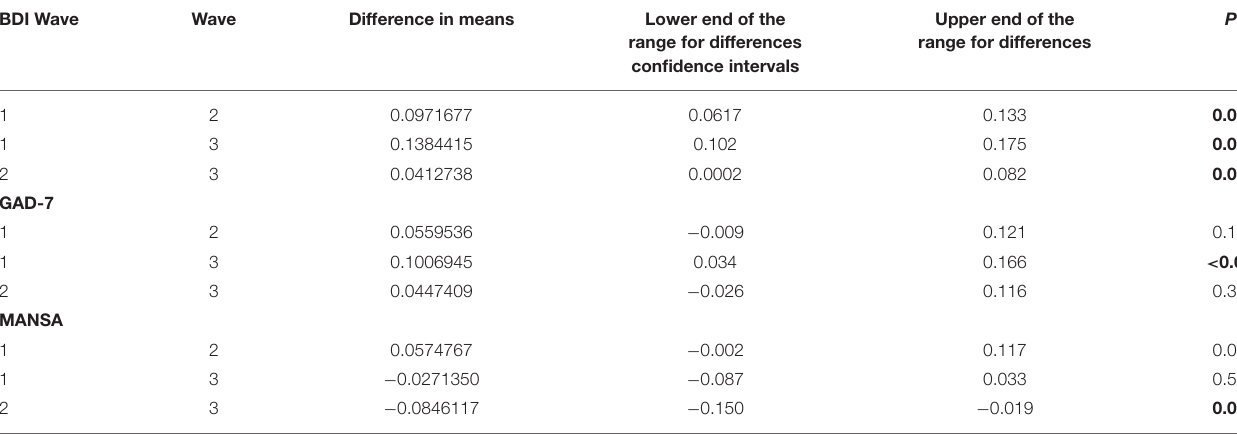
TABLE 2 | Comparison of BDI, GAD-7, and MANSA scores according to different stages of the study. BDI Wave Wave Difference in means Lower end of the